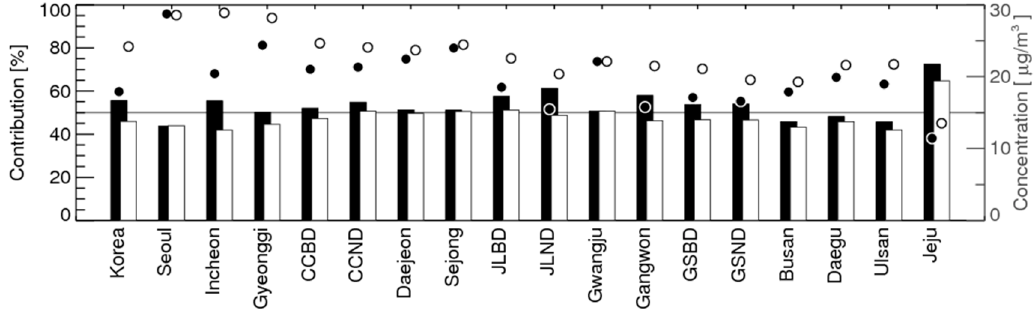
Figure 7. The eight-year average PM 2.5 concentrations (circles) and the Chinese contribution (bars) in the 17 provinces via the 9-km simulation. The black and white colors represent the area-based and monitor location-based Chinese contribution, respectively.